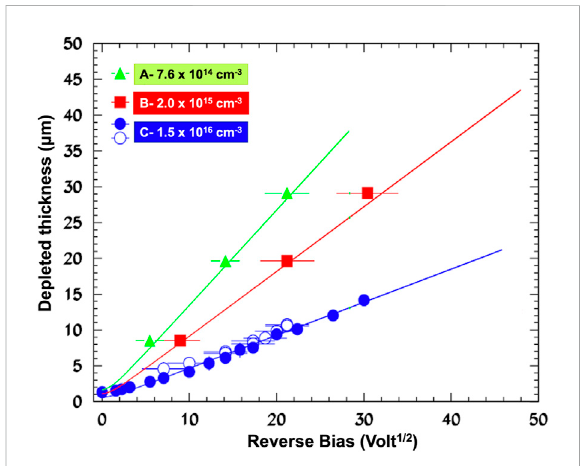
FIGURE 3 Thickness of the depleted epitaxial layer as a function of the applied voltage. Data from Ref. [58] are obtained using SiC Schottky diodes with three different epitaxial doping concentrations (reported in the fi gure). The effect of the doping concentrations is evident: the lower is the concentration the lower is the bias needed to deplete the same thickness of the diode. Lines represent calculations fromEq. 4obtained using aSiC static permittivity ϵ r = 9.66 ϵ 0 and a Schottky barrier height V built − in = 1.5 V